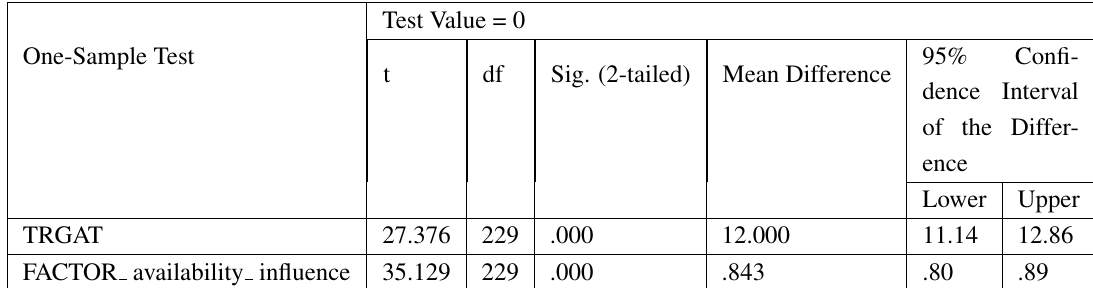
Table 2. agreement between theresponses of the sample on the degree of influence of the main variables andthe sub-result of the analysis of the questionnaire indicates One-Sample